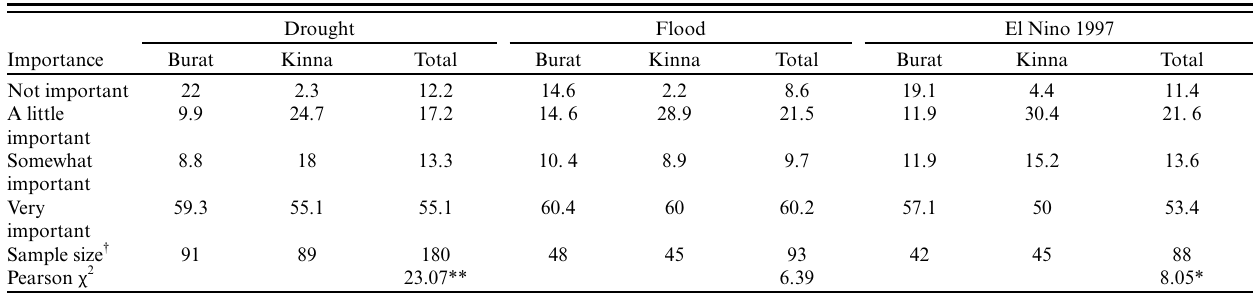
Table 4. Proportion (%) of survey respondents who listed agroforestry as being important for the household livelihood during drought, floods, and the 1997 El Niño flooding.